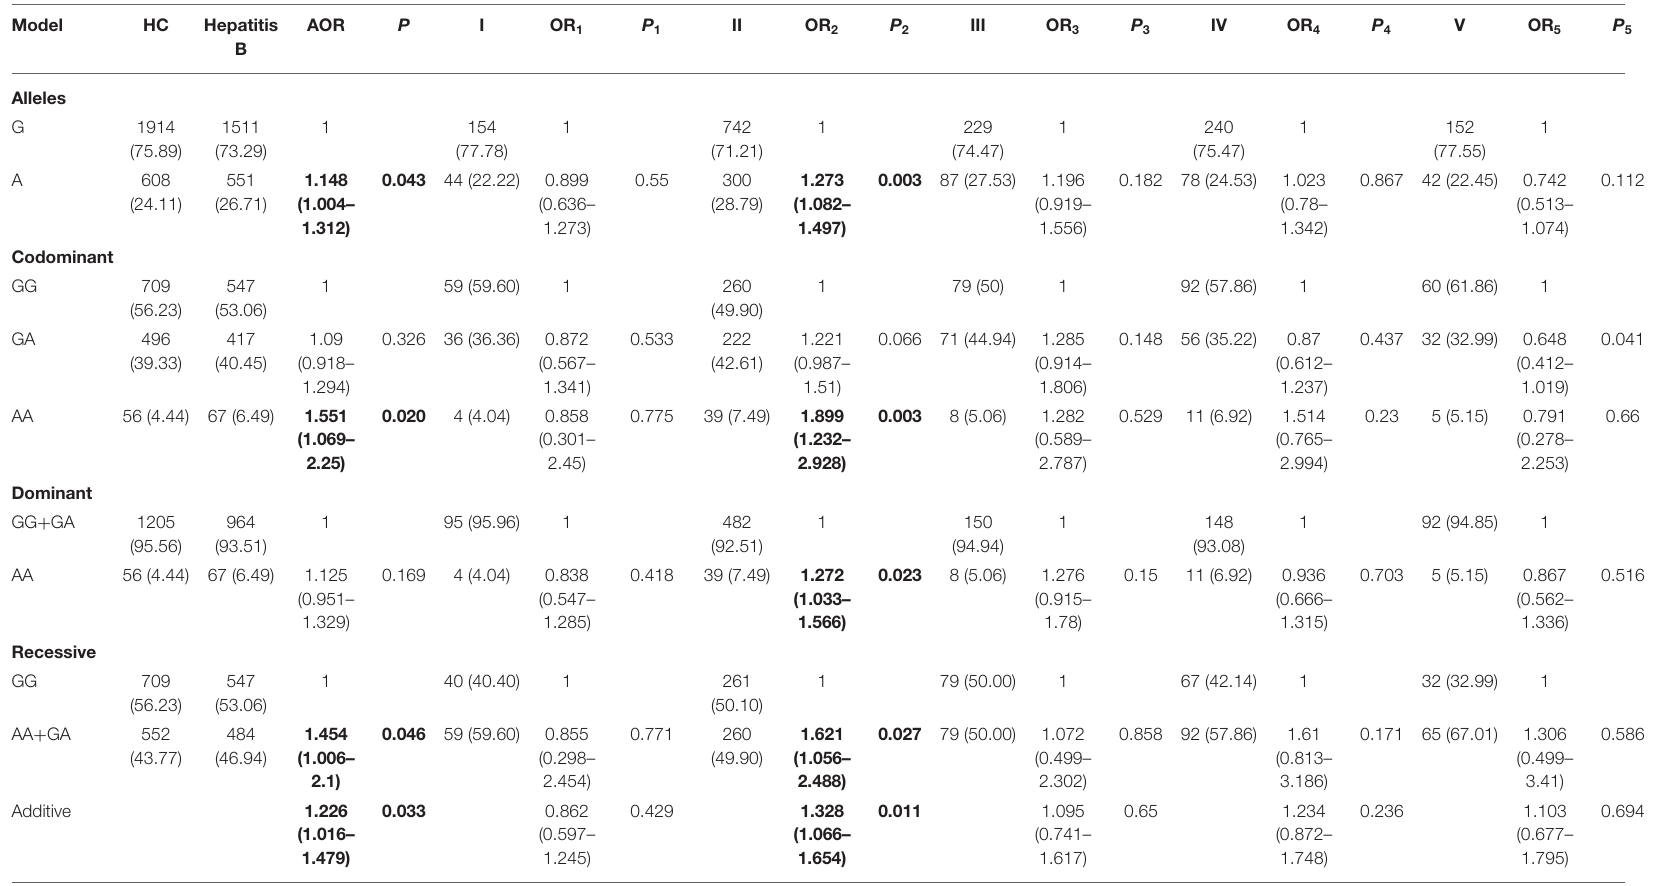
TABLE 2 | Association between rs671 and hepatitis B virus (HBV) infection in different hepatitis B groups.